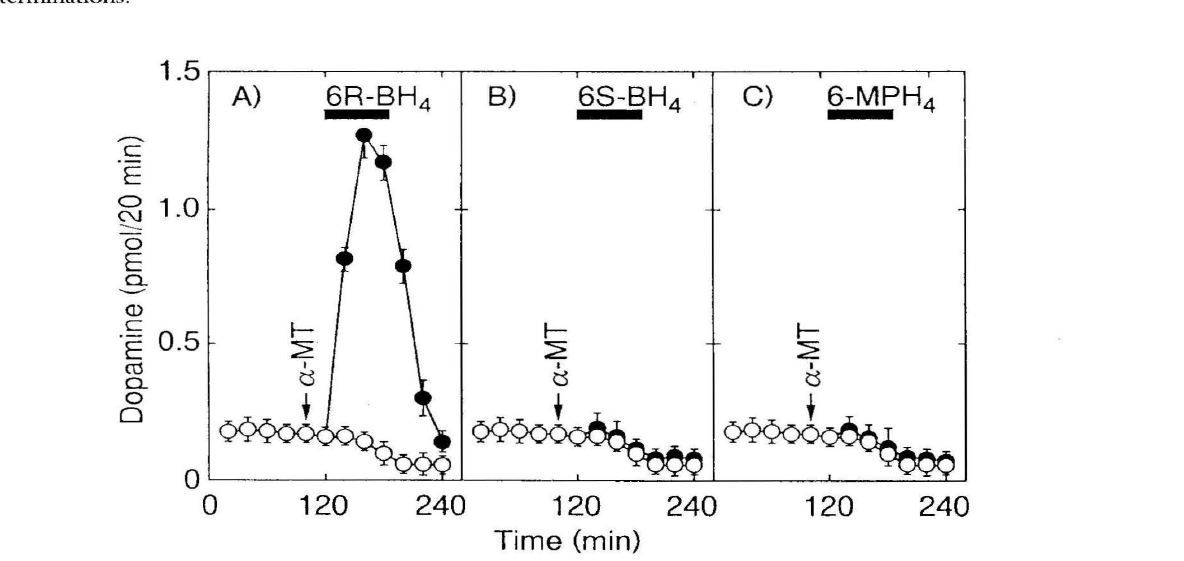
Figure 1. Effects of 6R-BH. (A), 6S-BH4(B) or 6-MPH 4 (C) added to the perfusion fluid on the extracellular DA lev els monitored by in vivo brain microdialysis. After DA levels in striatal dialysates reached a steady state, either of the pteridines was added to the perfusion tluid of microdialysis probes at a final concentration of 0.25 mM (filled triangles), 0.5 mM (filled squares), or 1 mM (tilled circles) during a 60-min period as indicated by a bar. Open circles represent the control group, in which the striatum was dialyzed without addition of pteridines. Each value is the mean ± SEM of four determinations.